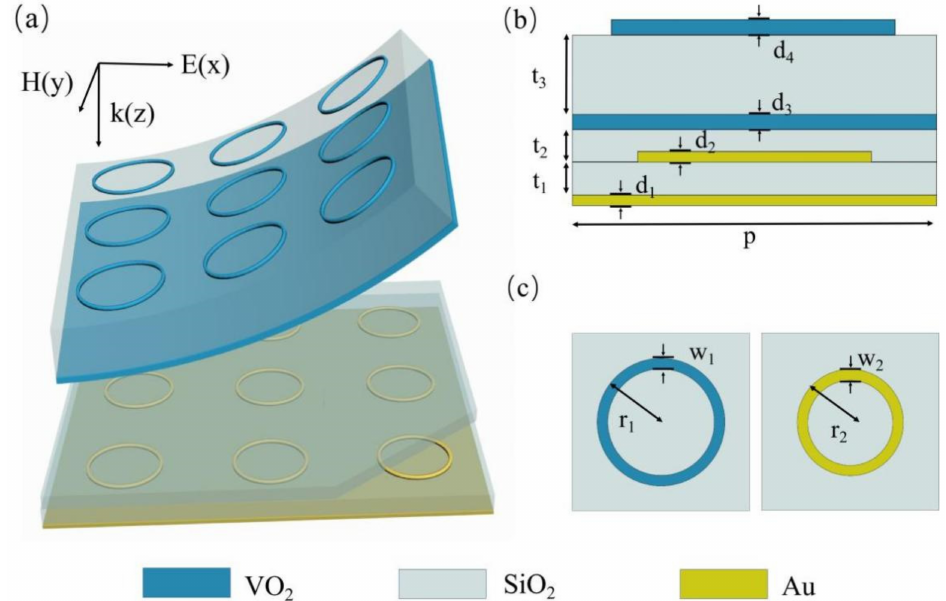
Figure 1. ( a ) Schematic of the proposed multi-band absorber. ( b ) Side view for one unit cell of the multi-layer composed structure. The detailed parameters are p = 85 µ m, t 1 = 6 µ m, t 2 = 5 µ m, t 3 = 20 µ m, d 1 = d 2 = 0.4 µ m, d 3 = d 4 = 1 µ m. ( c ) Top view for one unit cell of periodic VO 2 rings and Au rings, where r 1 = 40 µ m, w 1 = 4 µ m, r 2 = 25 µ m, w 2 = 2 µ